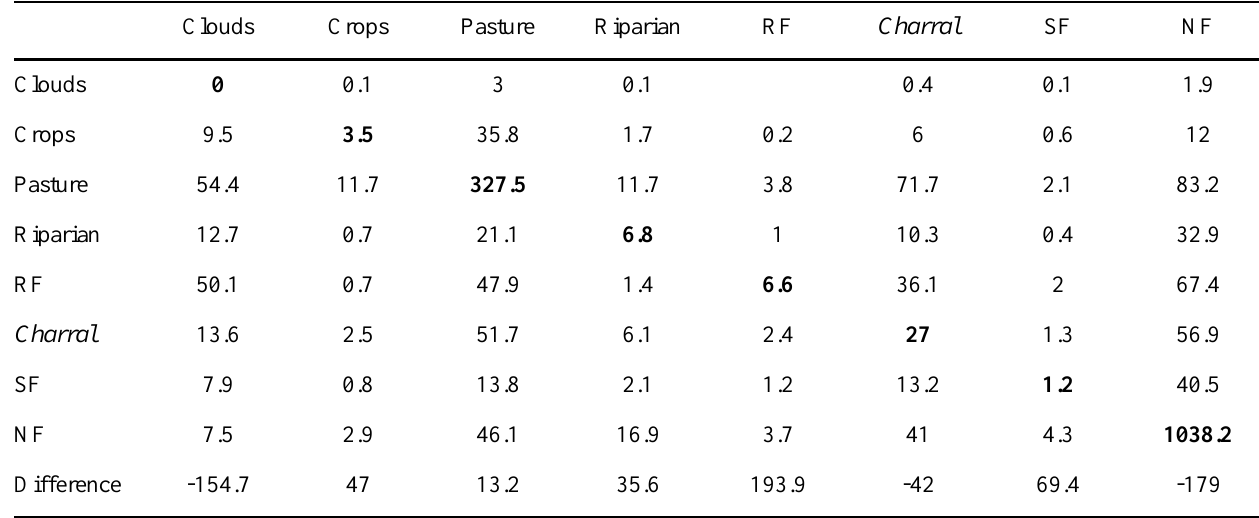
Table A1-1 . Land-cover changes from 1986 to 1996. Clouds Crops